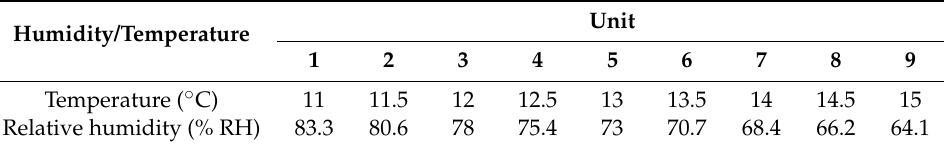
Table 2. The coupling relation of temperature and relative humidity at the proximity of 13 ˝ C and 73%